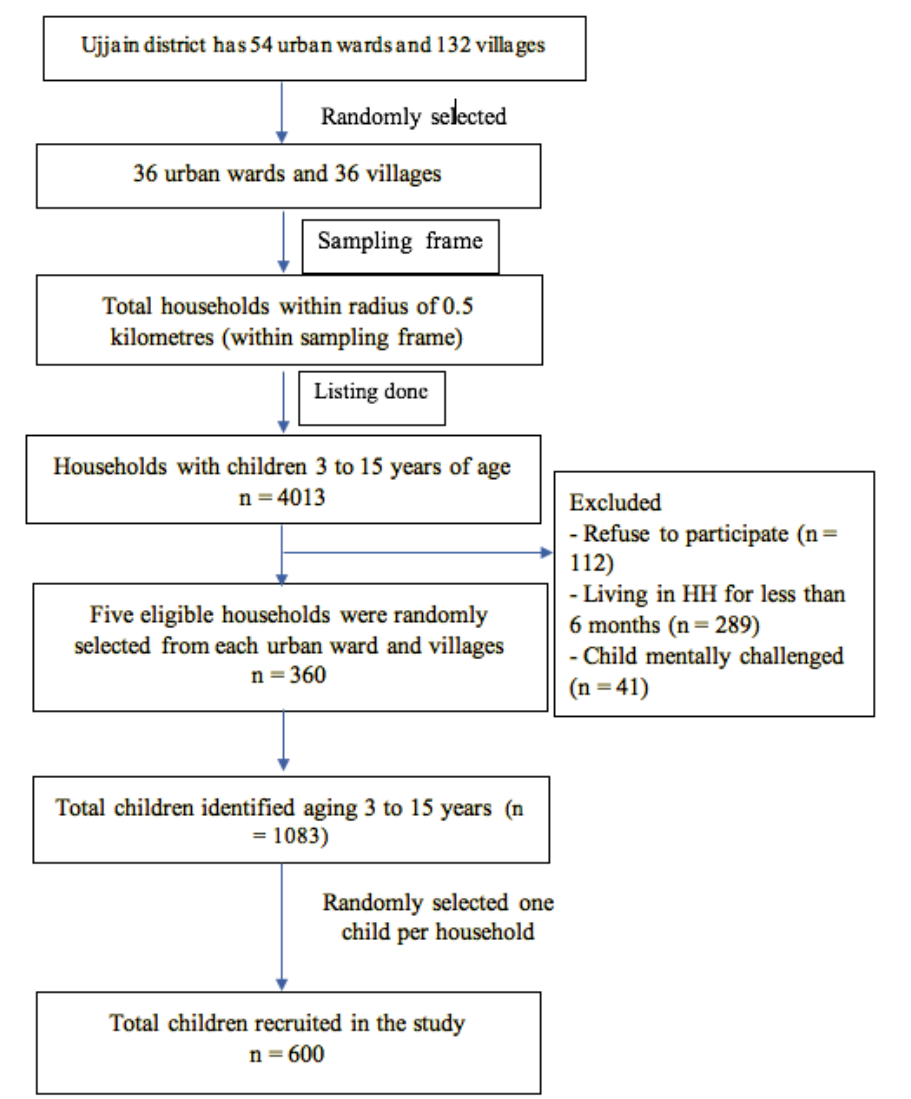
Figure 1. Sampling procedure followed in the